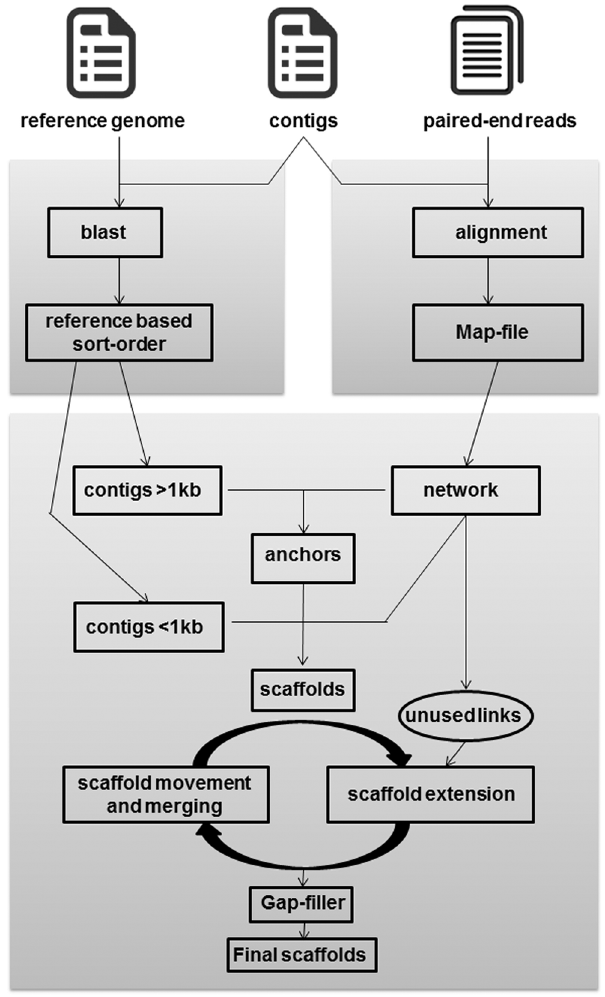
Fig 1. Schematic overview of CLA pipeline. The schema of CLA pipeline is divided into three stages. In the first stage, a reference based order is derived followed by the second stage where connections between the individual contigs are extracted based on alignment information. The final stage makes use of the information from the first two stages to decide the final order followed by scaffolding and gap